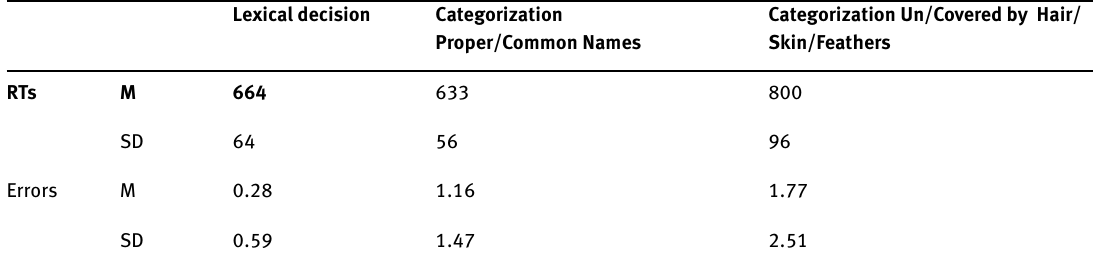
Table 3: Mean latency, mean accuracy and standard deviations for the lexical decision and two categorization